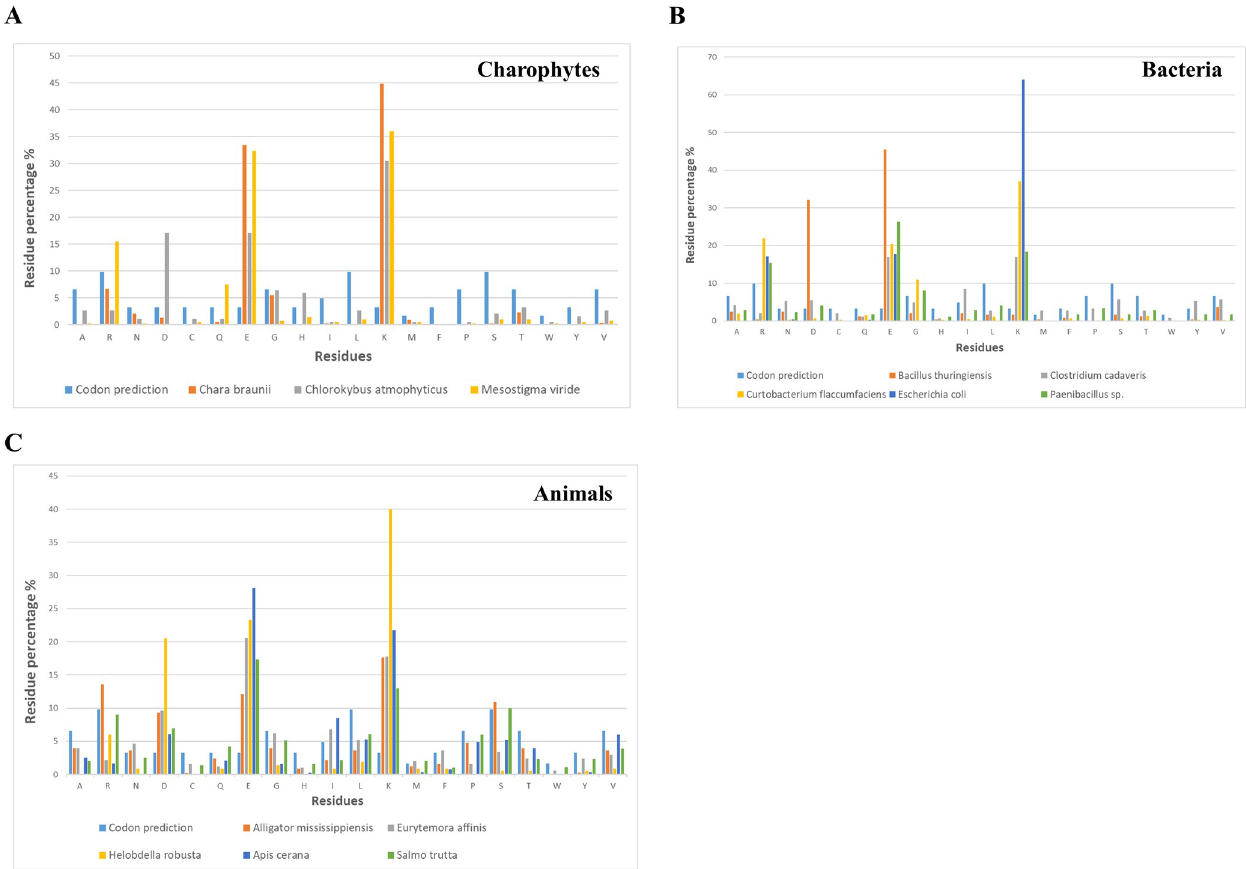
Fig 4. Residue percentage in several representative KED-rich proteins from evolutionarily diverse genomes. Percentage of each residue (in light blue) hypothetically predicted from available codons out of total 61 sense codons is compared to the percentage of each residue in the protein sequences. A , charophyte species; B , bacterial species; C , animal